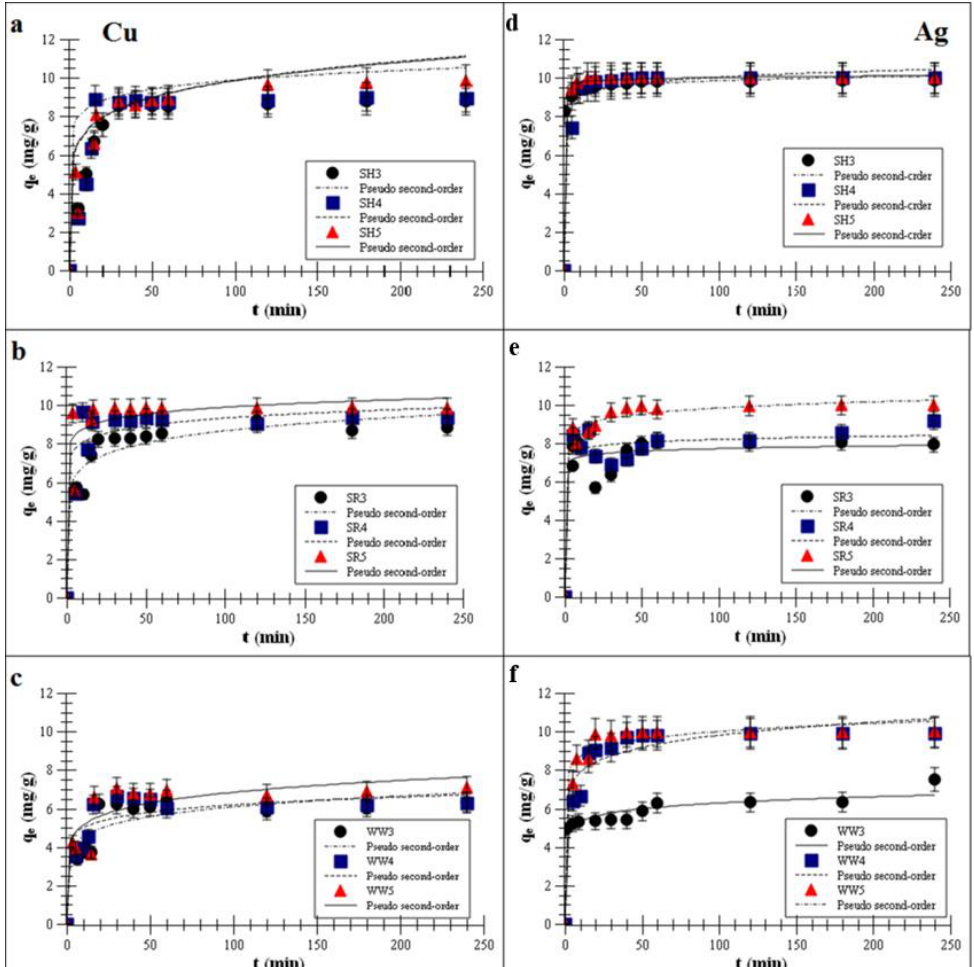
Figure 2. Pseudo-second-order fitting [35,36] of the metal adsorptions on the biochars ( a , d )biochar derived from sunflower husks; ( b , e ) biochar derived from sunflower husks and rapeseed pomace; ( c , f ) biochar derived from wood waste): SH3 (sunflower husks, 300 °C), SH4 (sunflower husks, 400 °C), SH5 (sunflower husks, 500 °C), SR3 (sunflower husks + rapeseed pomace, 300 °C), SR4 (sunflower husks + rapeseed pomace, 400 °C), SR5 (sunflower husks + rapeseed pomace, 500 °C), WW3 (wood waste, 300 °C), WW4 (wood waste, 400 °C) and WW5 (wood waste, 500 °C); q e is the heavy metal removal capacity at equilibrium; t is the time; Cu is copper and Ag is silver.